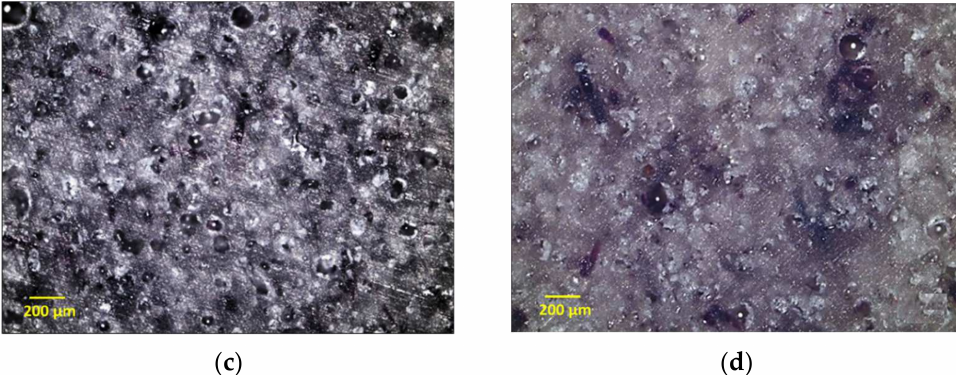
Figure 4. Optical images illustrating the dispersion by ( a ) magnetic stirring and ( b ) sonication of PUF-DCPD system and dispersion by ( c ) magnetic stirring and ( d ) sonication of MUF-ENB system.